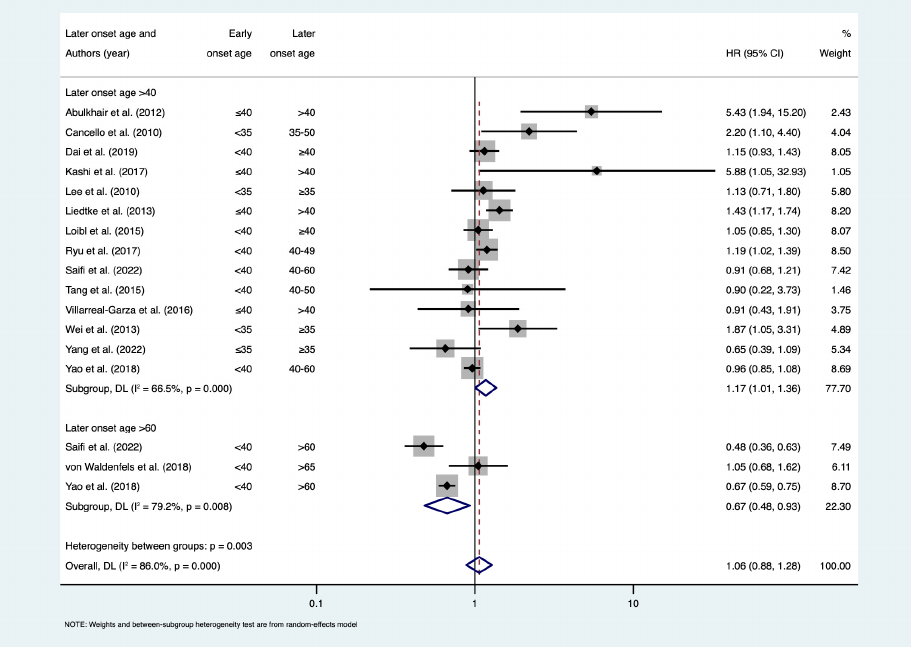
Figure 5. Forest plot for meta-analysis of overall survival. Hazard ratios less than 1 show favourable outcomes in early-onset age group; hazard ratios greater than 1 show poorer outcomes in early-onset age group. References [18,20,22,28,32,34,37,39–41,44–48]. Abbreviations: CI = confidence interval; HR = hazard